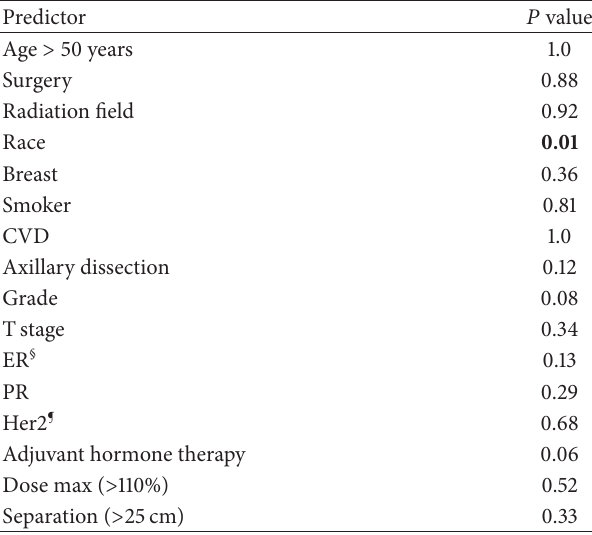
Table 2: Treatment break univariate analysis.